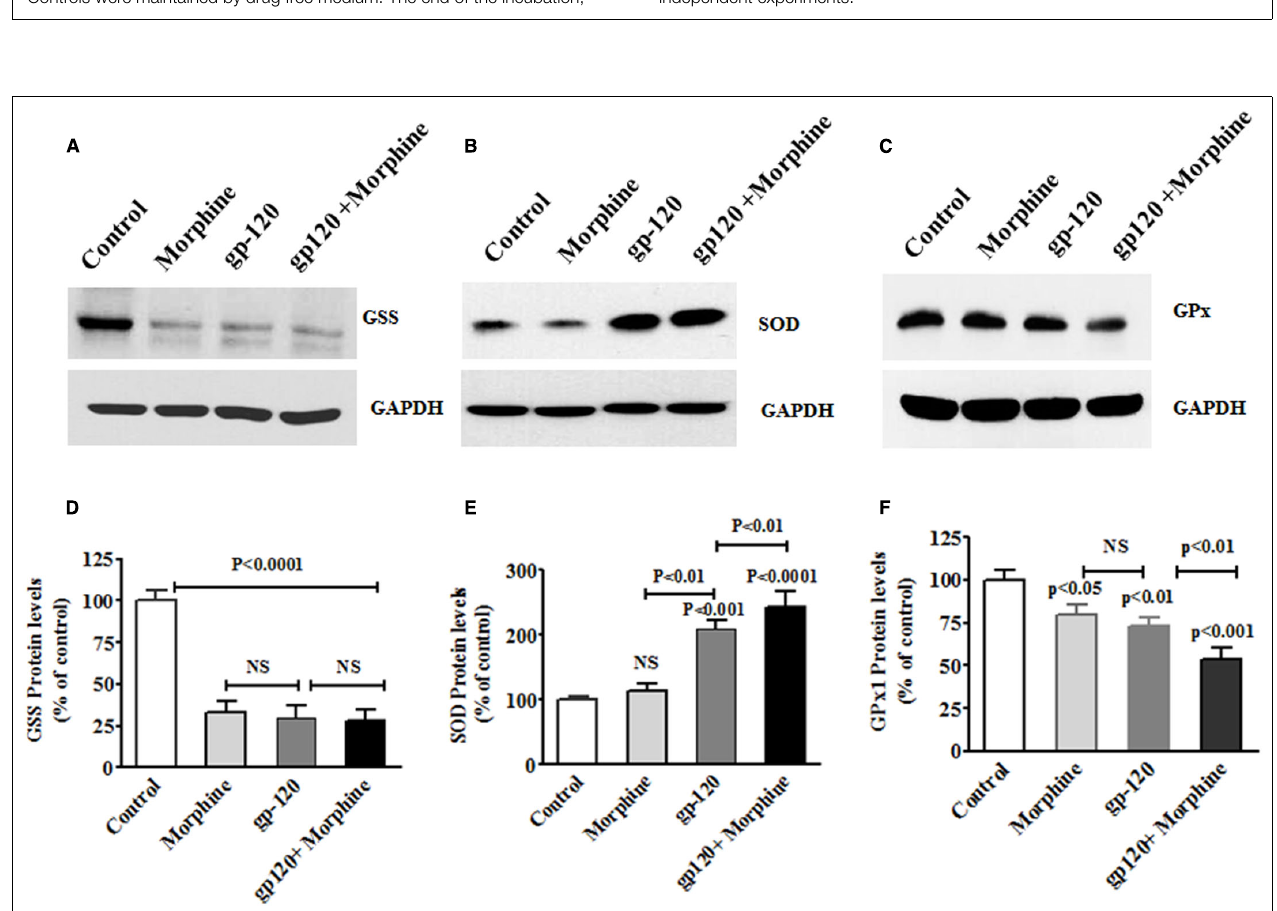
RNA was extracted and reverse transcribed followed by quantitative real time PCR for GSS (A) , SOD (B) , GPx (C) , and housekeeping β -actin specific primers. Data are expressed as mean (cid:6) SE of TAI values of three independent experiments.